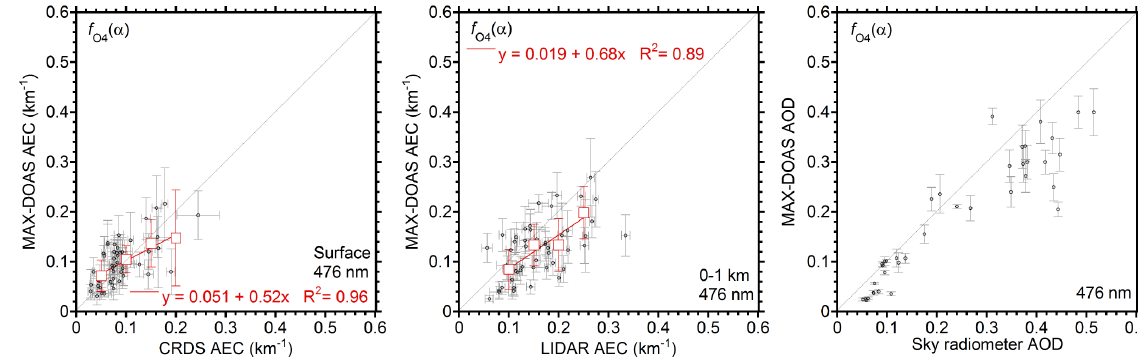
is assumed to be a function of α in the MAX-DOAS retrieval. 4